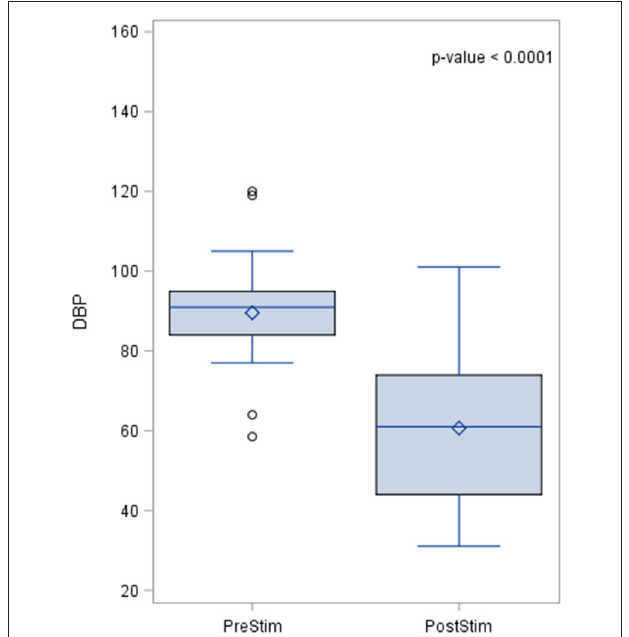
FIGURE 4 | Effects of baroreceptor stimulation on mean arterial pressure. The results of the distribution of the median are shown in the figure, together with the p -value after applying the Wilcoxin rank test. Mean arterial pressure values are represented in